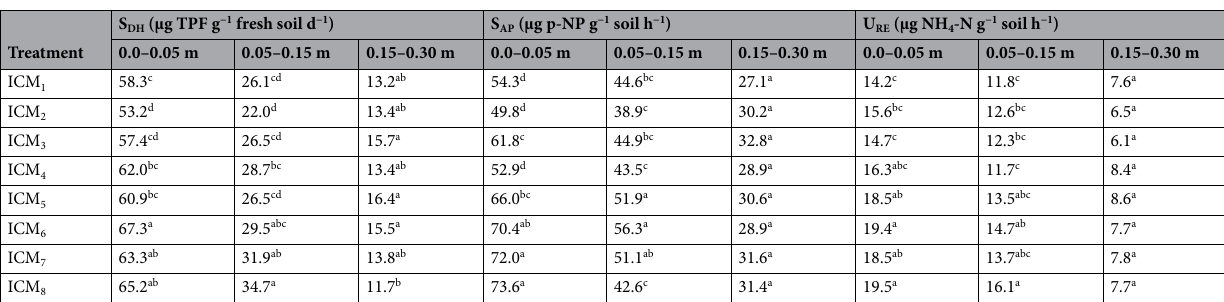
Table 3. Effect of different ICM modules on soil dehydrogenase activity (S DH ), alkaline phosphatase (S AP ) and urease (U RE ) at the flowering of 5 th season wheat under M WR . Means followed by a similar lowercase letters within a column are not significantly different at p < 0.05 according to Tukey’s HSD